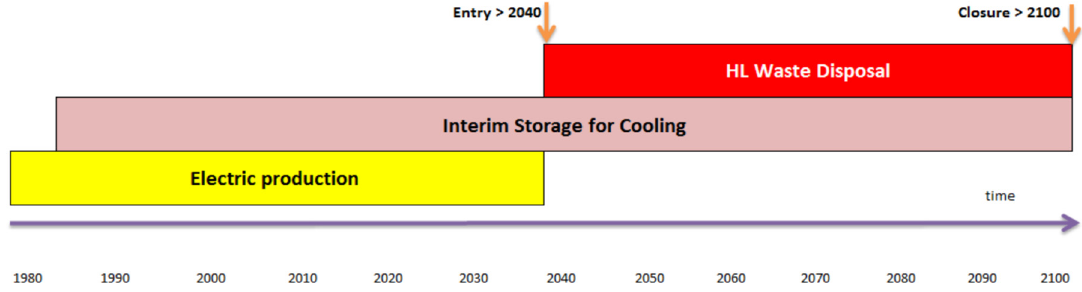
Fig. 1. Impact of the cooling period on the space required for waste package disposal (French clay